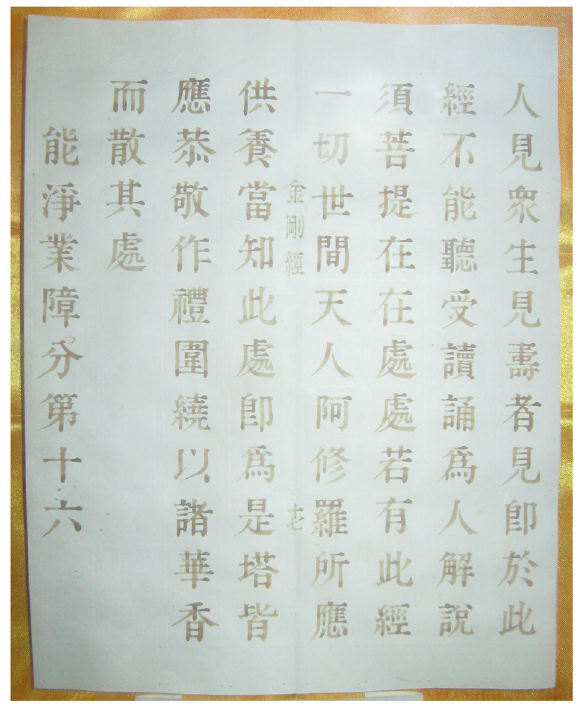
Fig. 2 Two-page spread of the Diamond S ū tra by a Qing Dynasty monk. The spread measures 8 × 14 inches. Currently, it is housed in the monastic library of Yongquan Monastery on Mount Gu in Fujian